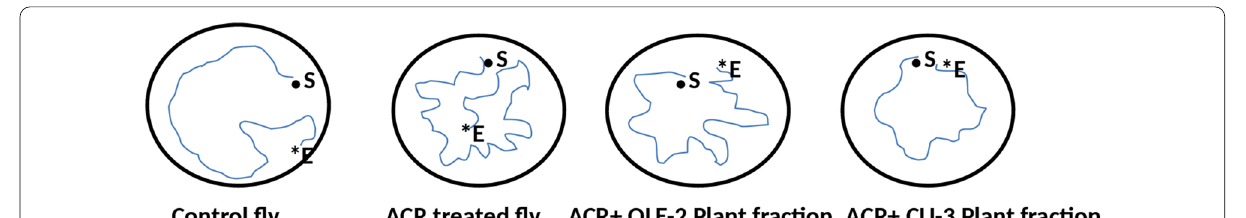
plant fraction treated fly, ACR treated fly move irregularlycompared to ACR +